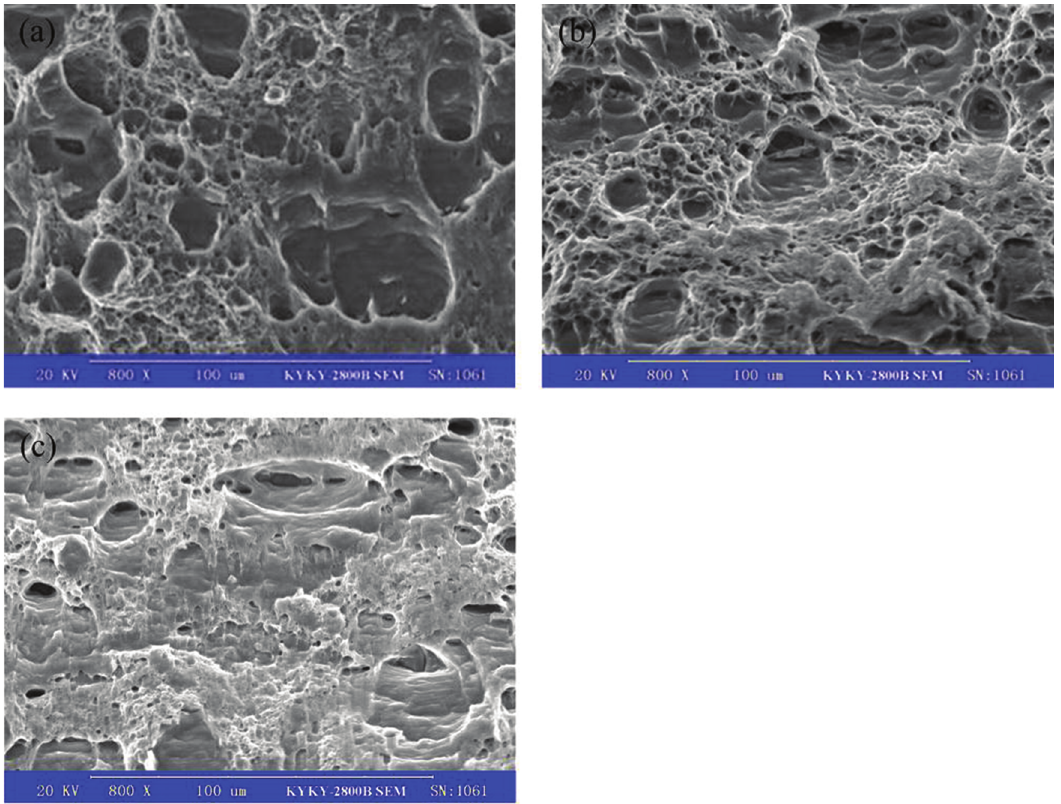
Figure 13: Fracture morphologies of welding joints at different welding speeds: (a) 50 mm/min, (b) 100 mm/min and (c) 200